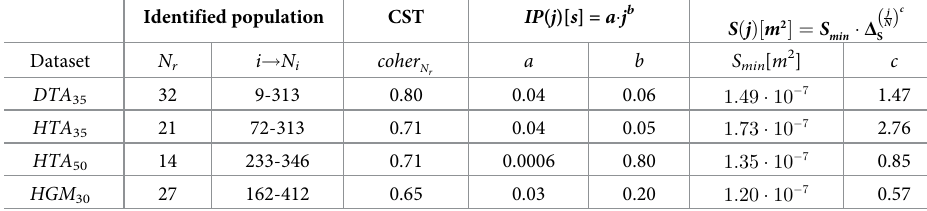
Table 2. Intermediary results obtained for the datasets DTA 35 , HTA 35 , HTA 50 and HGM 30 from the three first steps of the approach. For each dataset are reported (1) the locations in the complete pool of N MNs of the lowest- (N 1 ) and highest-threshold ( N ) MNs identified experimentally, (2) the coher value between the experimental and N r N r virtual cumulative spike trains (CST), and the coefficients defining the distributions in the complete MN pool of (3) the inert period (IP) parameter and of (4) the MN size (S). For the TA and GM muscles, N = 400 and N = 550